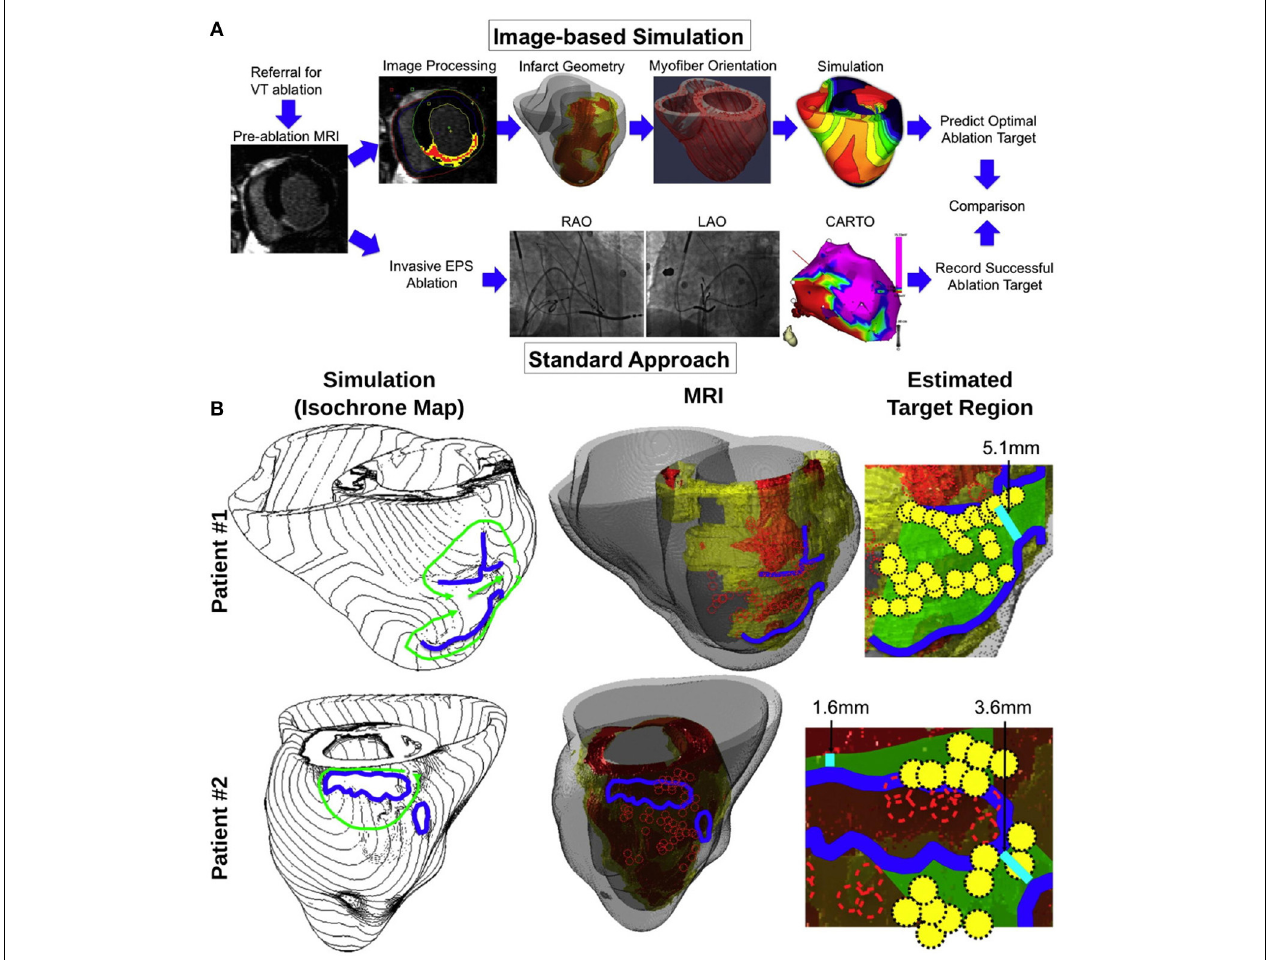
FIGURE 6 | (A) Proposed simulation-guided approach for determining the ablation targets of infarct-related ventricular tachycardia. The patients referred for ventricular tachycardia (VT) ablation undergo pre-ablation MRI, which was processed to provide the heart and infarct geometry (scar: red; GZ: yellow). These geometrical data were incorporated into a model of VT to estimate potential target regions. This method is alternative to an invasive electrophysiology study (EPS), and ablation [“Standard Approach”; by using biplane X-ray fluoroscopy and electroanatomical mapping (CARTO)]. LAO—left anterior oblique; RAO—right anterior oblique. (B) Comparison between simulation-guided and standard electrophysiological approaches for identifying endocardial ablation targets in two patients with infarct-related